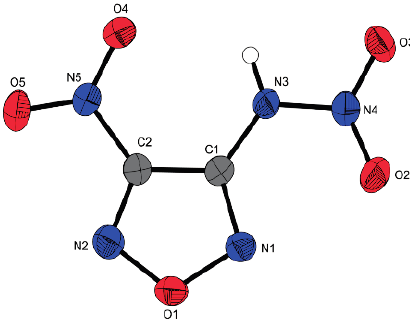
Figure 3. Molecular unit of 4 . Ellipsoids are drawn at the 50% probability level.